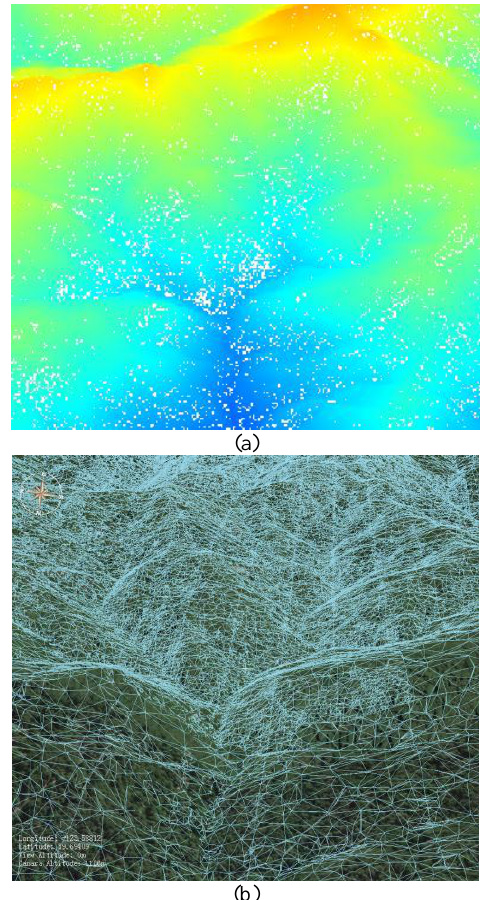
Figure 6. Multi-resolution TIN surface modelling and visualization for LiDAR elevation points. (a) rough LiDAR points. (b) Multi-resolution TIN